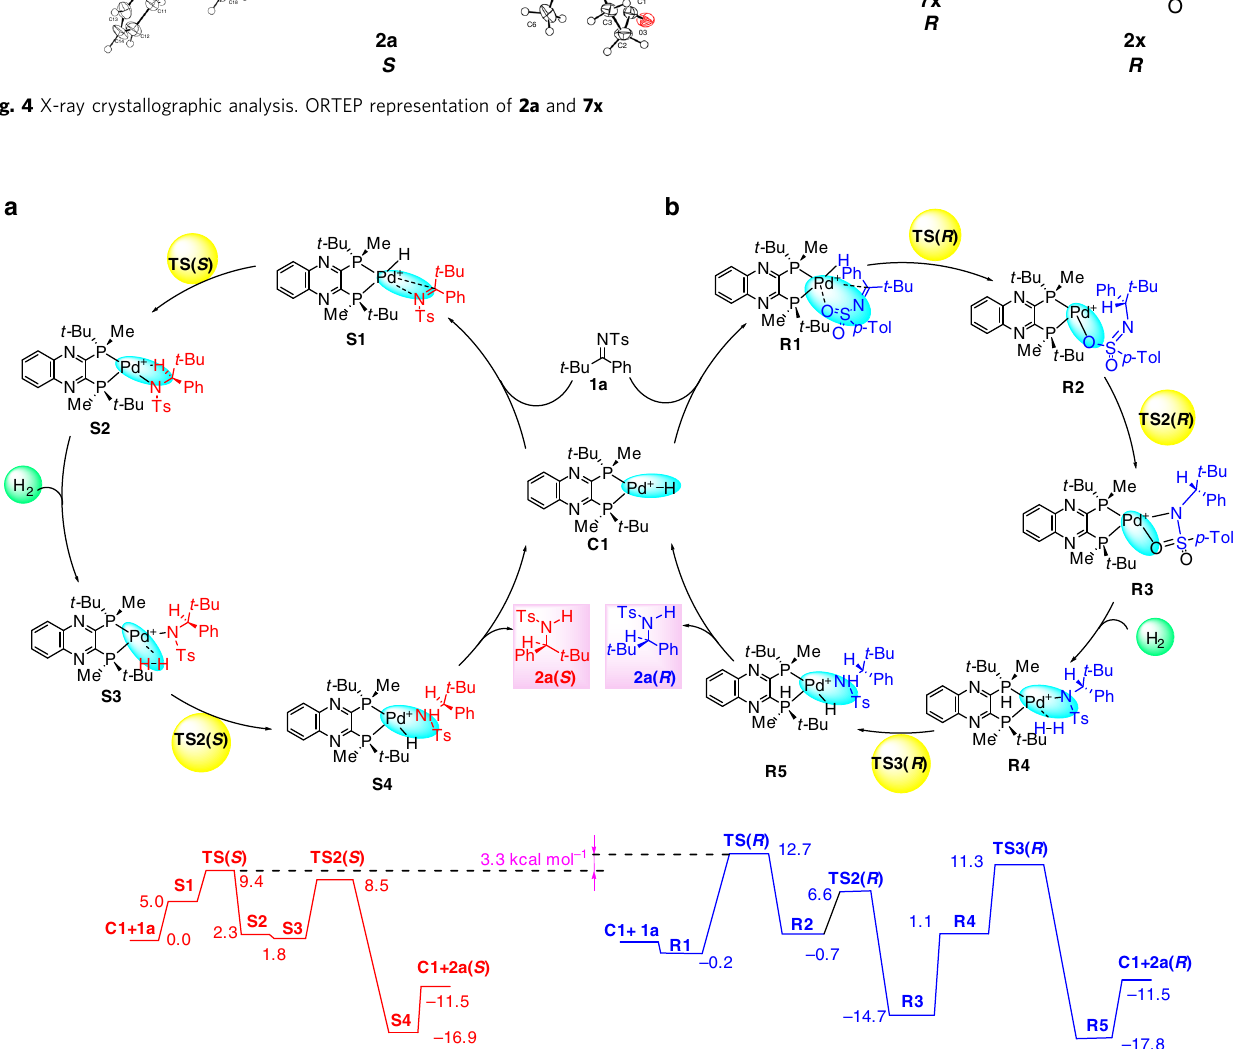
Fig. 5 Computed catalytic cycles for 1a . Relative Gibbs free energies in kcal mol – 1 are shown (WB97XD/6-31g(d,p)/SMD(2,2,2-tri fl uoroethanol, 298.15K. 1